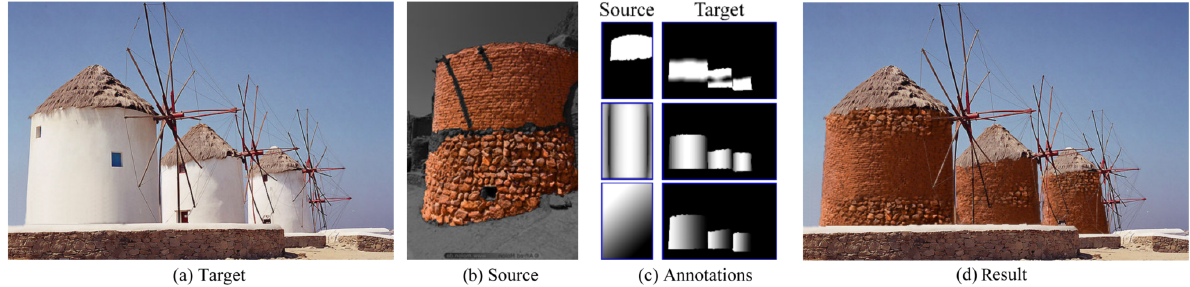
Fig. 18 Complex material synthesis results from Diamanti et al. [97]. The target image (a) is used as a backdrop and the source (b) is used as an exemplar for the patch-based synthesis process. The artist creates annotations (c) for different properties of the material, such as large versus small bricks, the normal, and lit areas versus shadow. A result image (d) is synthesized. About 50% of the desired patch annotations were not seen in the exemplar, and were instead interpolated between the known materials. Reproduced with permission from Ref. [97], c (cid:13) Association for Computing Machinery, Inc.